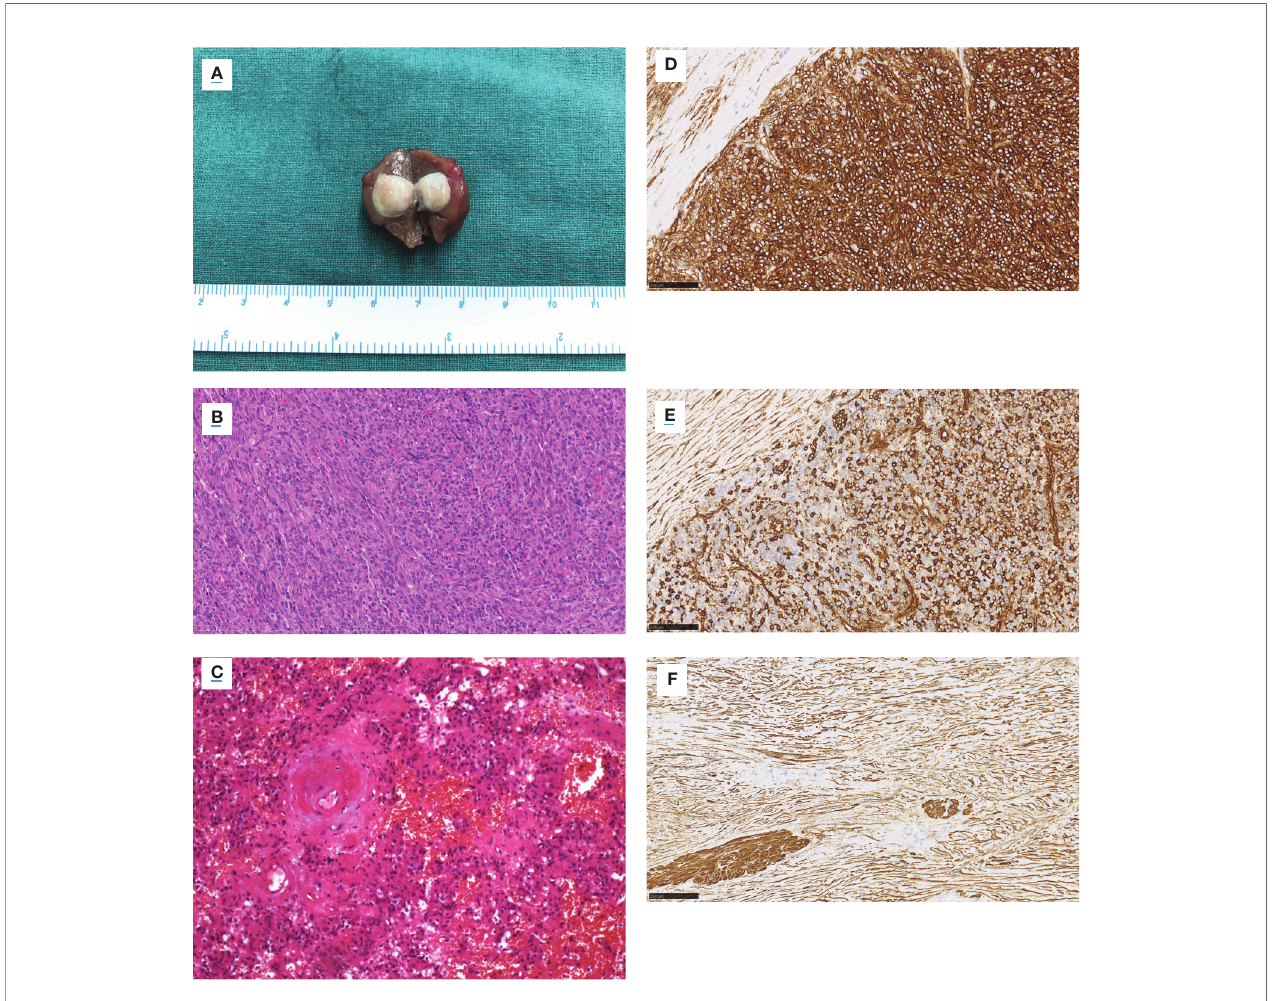
FIGURE 5 | Gross view, microscopic view, and immunostainings of Patient No. 8. (A) Gross view. Microscopic view (HE staining) showing (B) the polygonal and spindle cells, (C) the thickened hyalinized vessel wall and focal hemorrhage. The immunostaining of (D) CD34, (E) vimentin, and (F) smooth muscle actin. (B – F) Magni fi cation